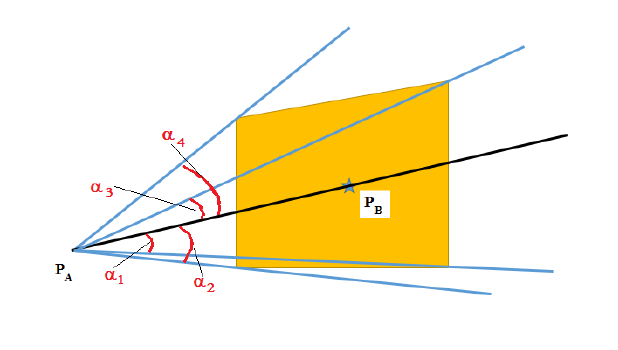
Figure 12. Vehicle A at position P A faces one polygonal obstacle B . The centroid of the polygon is at P B . The vector P A P B pass through P A and P B